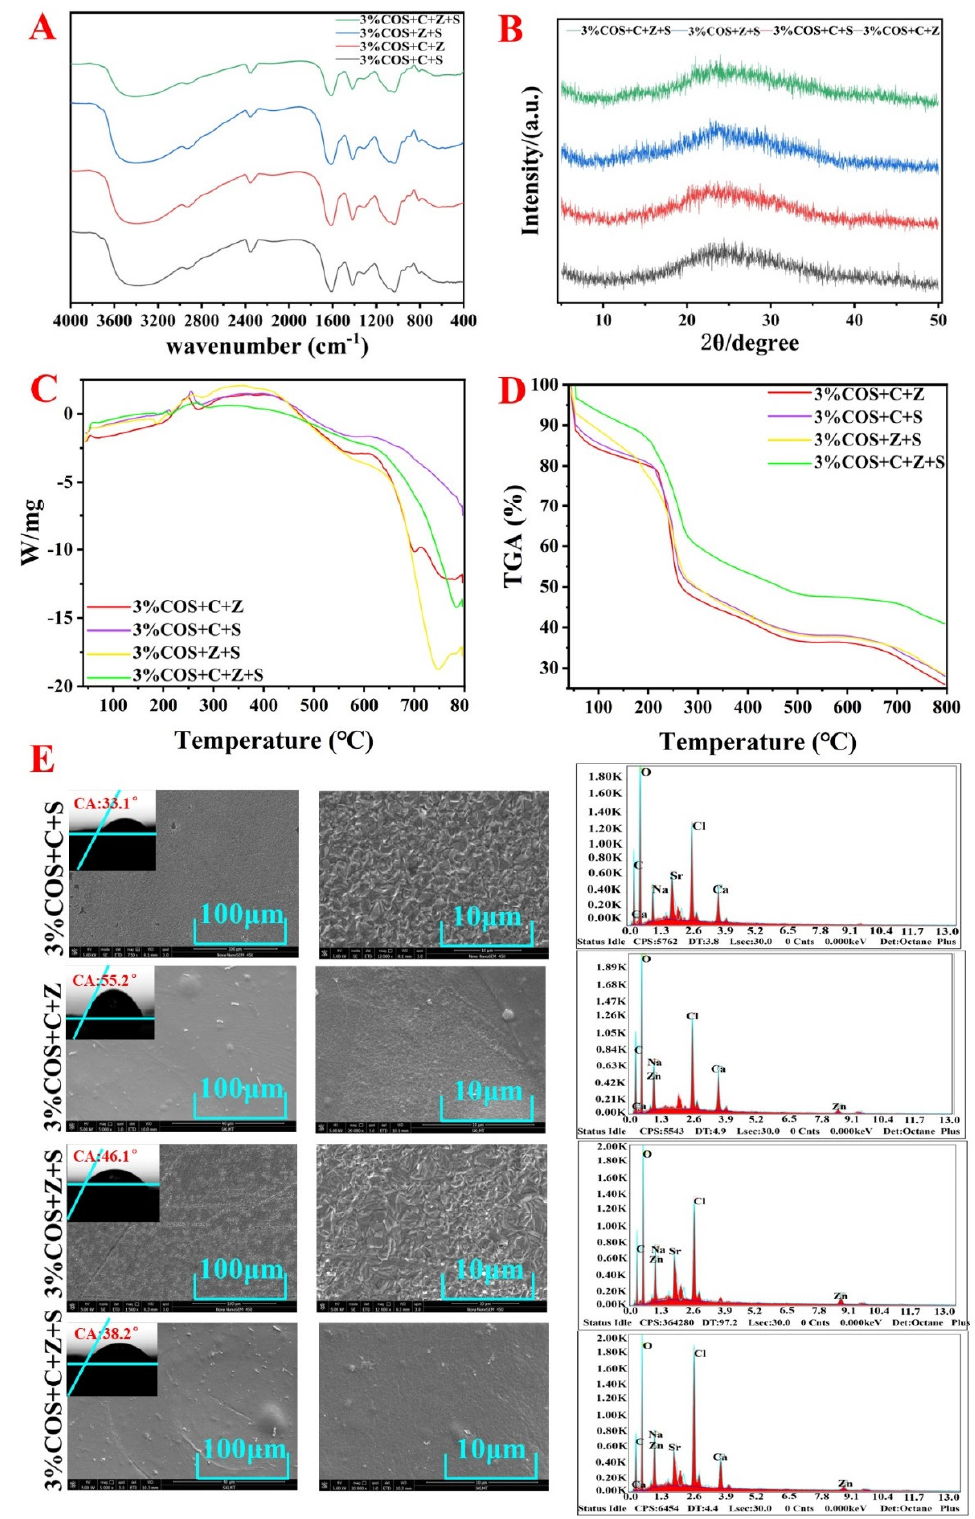
Figure 1. Characterization of nIon 2+ − COS/SA gel films. ( A ) FTIR spectra of nIon 2+ − COS/SA gel films. ( B ) XRD patterns of nIon 2+ − COS/SA gel films. ( C , D ) TGA patterns of nIon 2+ − COS/SA gel films. ( E ) SEM morphology and energy spectrum analysis of nIon 2+ −COS/SA gel films.